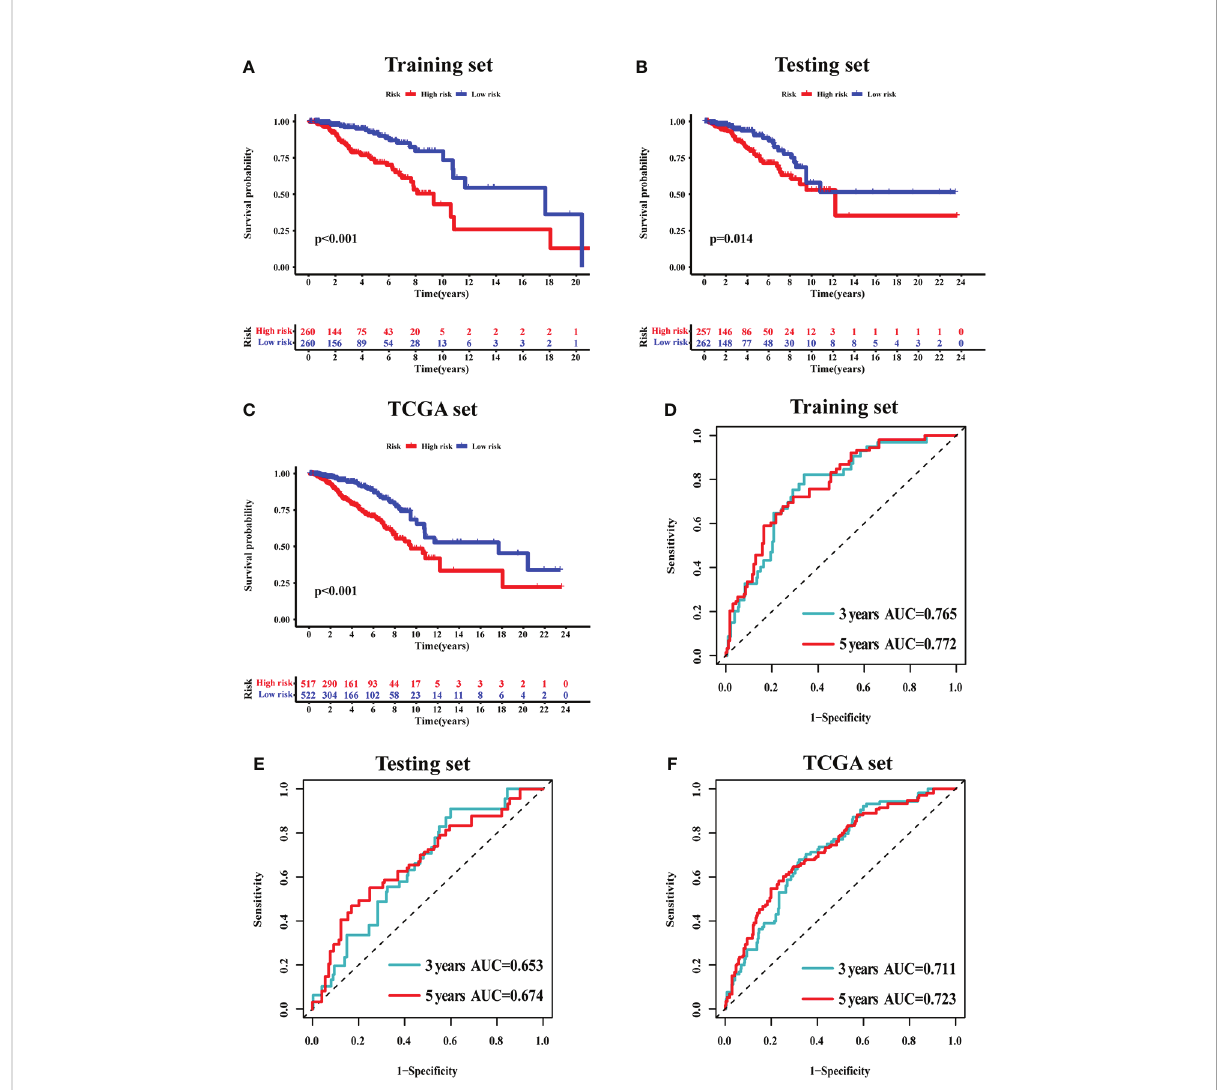
FIGURE 5 The prognostic value of the 6-GI-related lncRNA prognostic model in breast cancer patients. Overall survival was estimated by Kaplan – Meier for patients with a low or high risk predicted by the lncRNA-related model in the training set (A) , testing set (B) , and TCGA set (C) . Time-dependent ROC curves analysis of the lncRNA-related model was performed for 3-year and 5-year overall survival in the training set (D) , testing set (E) , and TCGA set (F) . AUC, area under ROC curve; ROC, receiver operating characteristic; TCGA, The Cancer Genome